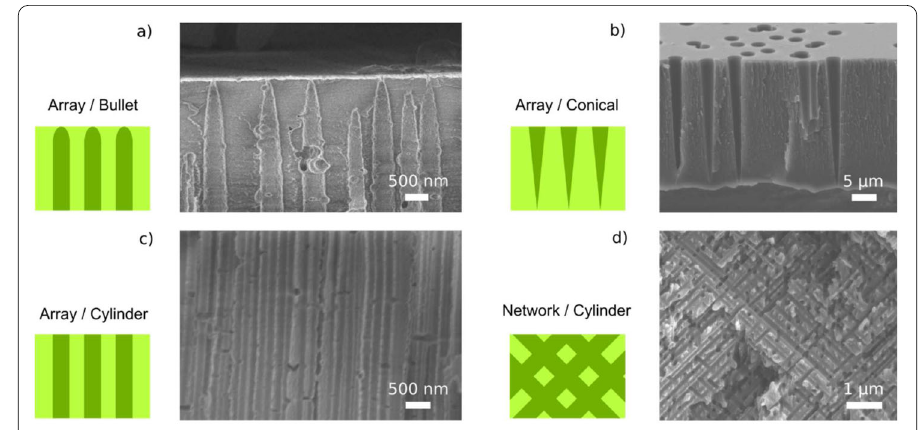
Figure 2 Schematics and scanning electron microscopy images of various pore geometries in ion track-etched membranes illustrating channels with ( a ) asymmetric bullet-like and ( b ) conical shapes, as well as ( c ) symmetric cylindrical parallel and ( d ) interconnected arrangements. Partially adapted from L. Burr, PhD Thesis, Technische Universität Darmstadt, 2017 and L. Movsesyan, PhD Thesis, Technische Universität Darmstadt,